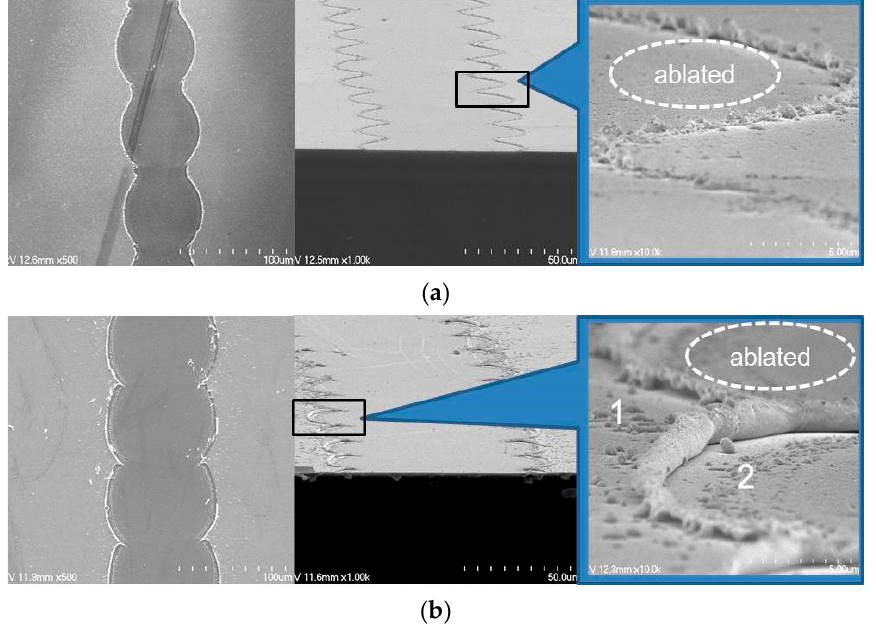
Figure 8. SEM images of laser-ablated ITO/Ag/ITO MLs with different Ag thickness of ( a ) 0, and ( b ) 13 nm at scanning speed of 1000 mm/s and laser pulse energy of 163 μ J. Table 1. EDX results of laser-ablated ITO/Ag/ITO ML patterns shown in Figure 8.